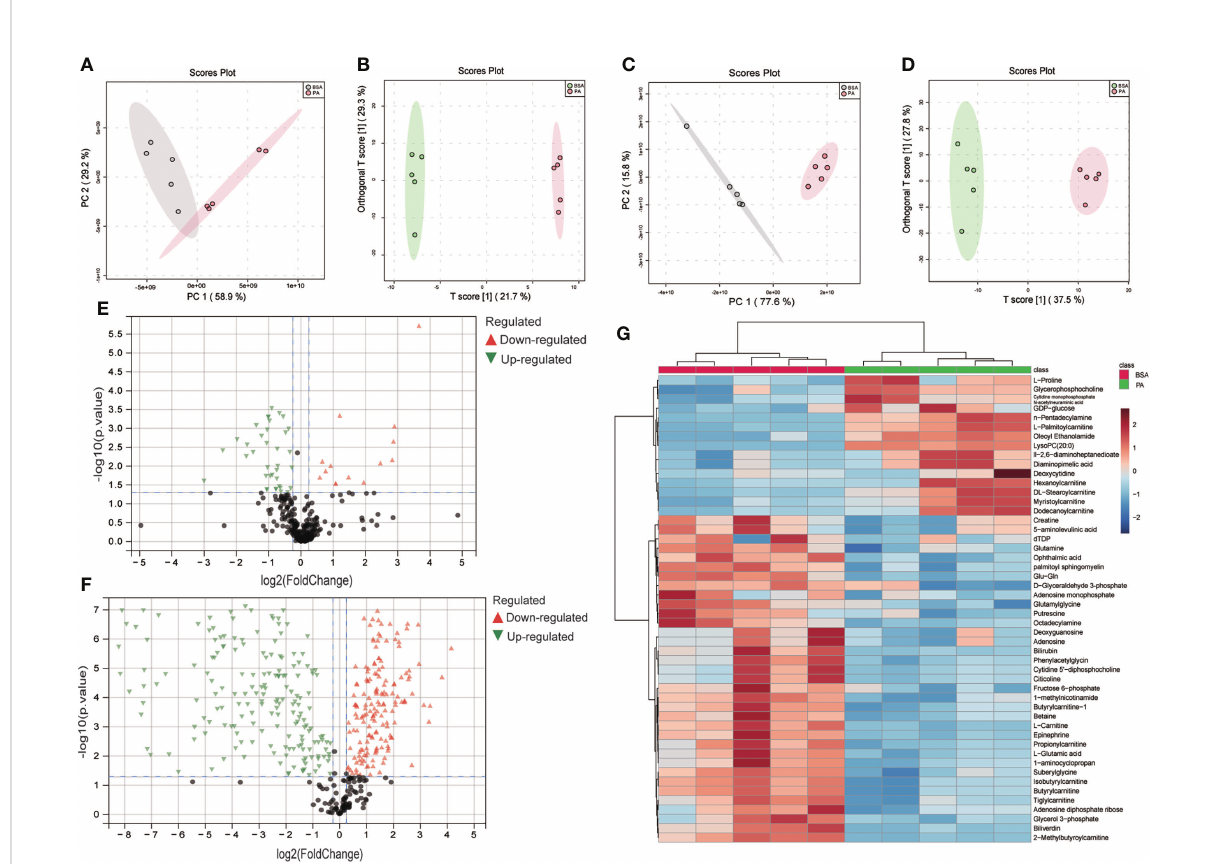
FIGURE 1 Metabolomics and lipidomics revealed global changes to metabolites in PA-treated SCs. PCA and OPLS-DA score plots between the BSA group and PA group in metabolomics (A, B) and lipidomics (C, D) . Volcano plots of the BSA group vs. the PA group in metabolomics (E) and lipidomics (F) . Heatmap showing differential polar metabolites in SCs treated with PA (G)